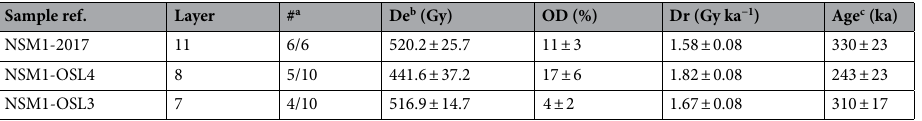
Table 2. IR-RF age results. a Number of aliquot giving an IR-RF signal/measured. b Unweighted mean ± se. c Calculated using DRAC v.1.2 28 , given at 1 sigma.